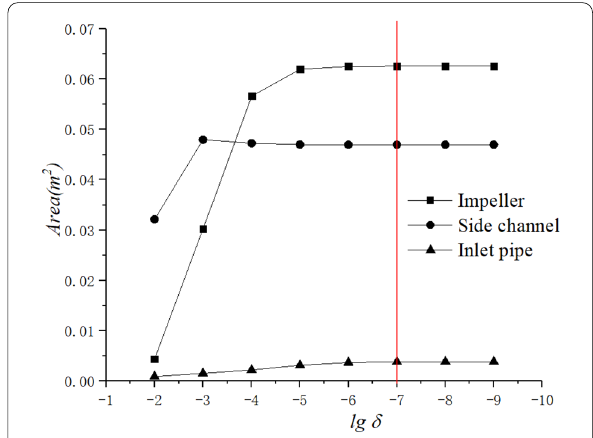
Figure 5 Dependency analysis of δ value